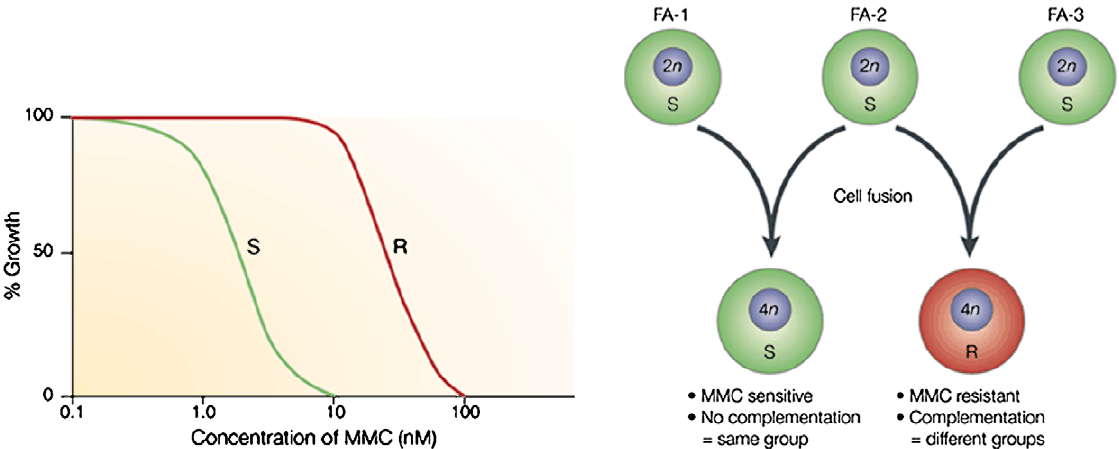
Fig. 2. Complementation analysis in FA. If two patient cell lines are fused together, the hybrid cell can either become sensitive (S, in which 50% growth reduction (IC50) is seen at a concentration below 10 nM MM) or resistant (R, with an IC50 value of more than 10 nM of MMC). An MMC-sensitive cell line indicates that both patient cell lines are defective in the same FA gene and therefore belong to the same complementation group (green hybrid cell). If, however, a hybrid cell becomes resistant to MMC, the result indicates that the cell lines are defective in different FA genes, so that the MMC sensitivity is corrected (red hybrid cell). (Figure reproduced with permission from Nature Reviews Genetics (Joenje and Patel) [67] c (cid:2) (2001) Macmillan Magazines